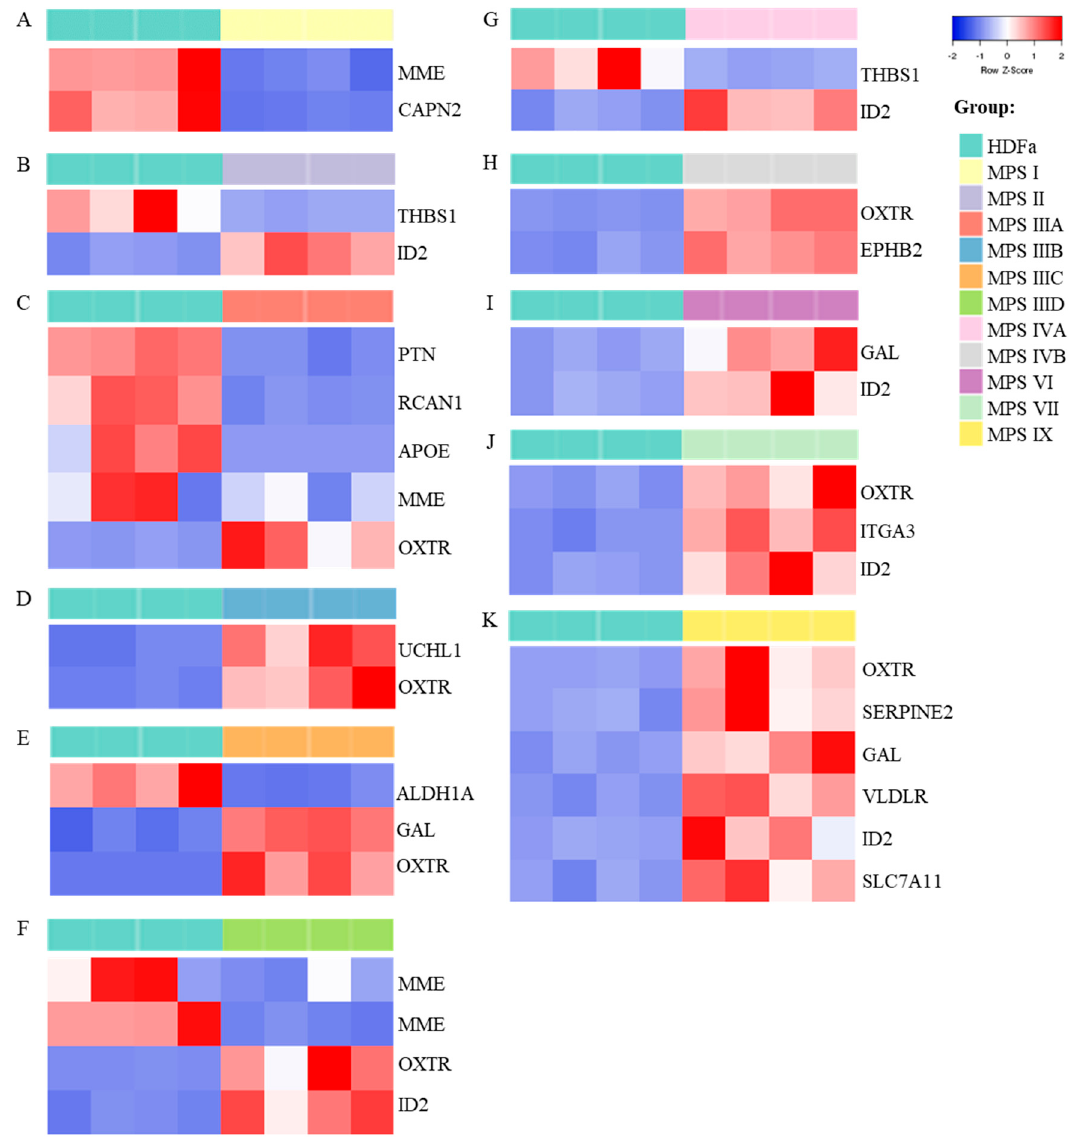
Figure 5. Genes which expression is particularly significantly changed (log 2 FC > 2.5) in different MPS types / subtypes relative to control cells – heat maps. Heat maps of transcript levels are presented for each MPS type (types: I, II, IIIA, IIIB, IIIC, IIID, IVA, IVB, VI, VII and IX in panels A – K , respectively), relative to control cell line (HDFa), with 4 biological repeats indicated in each case. Names of genes are indicated at the right side of each panel. The scale of changes in shown below panel K.